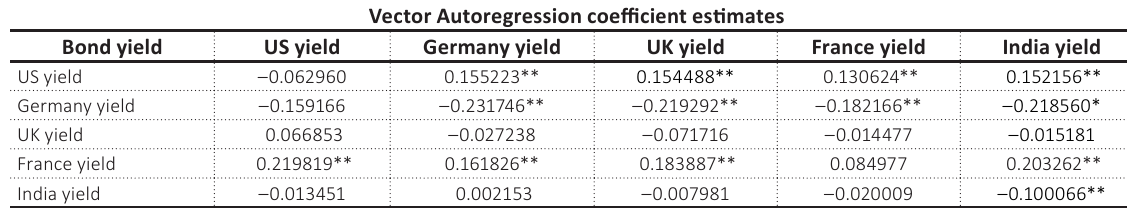
Table 4. VAR parameters for the post-Brexit vote era